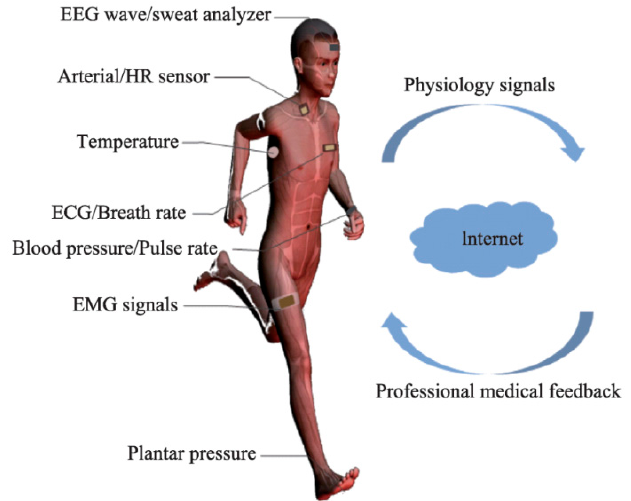
Figure 2. Monitoring of some physiological signals using flexible sensors and diagnosis and evaluation per remote medicine. Adapted from [41]. The abbreviations EEG, HR, ECG, and EMG stand for electroencephalogram, heart rate, electrocardiogram, and electromyogram,